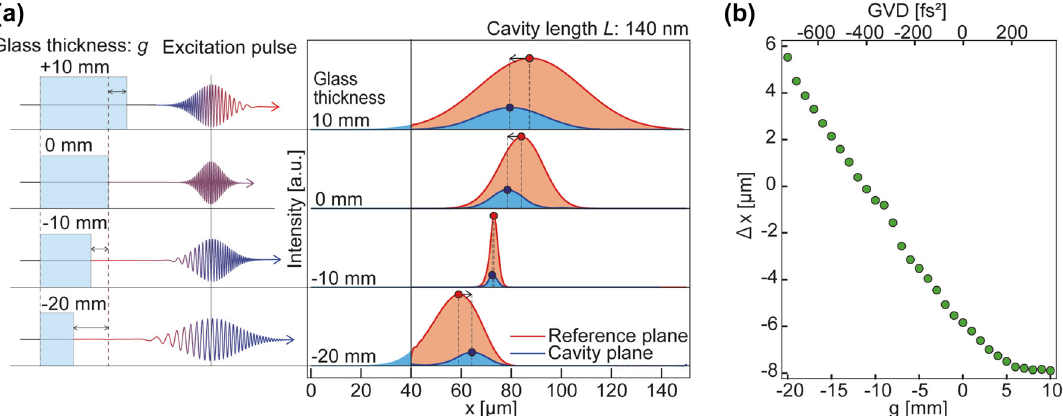
Figure 5: Control of peak shift of SPP WP by the chirp-induced excitation pulse. (a) Envelope shape of SPP WP calculated by CD model for reference plane (red plots) and cavity plane (blue plots) containing MIM-NC with L = 140 nm under several chirped pulse conditions. The red andbluecirclesindicatethecoordinatesoftheintensitymaximaoftheSPPWPsinthereferenceandcavityplanes,respectively.Thetemporal waveformsof achirp-inducedexcitationpulseareschematically shown.The groupvelocity dispersion(GVD)ofeach pulsecorrespondsto the amountofchirpcausedbythetransmissionofthesilicaglasswitheffectivethickness g = − 20to10mm.(b)Extentofpeakshift( Δ x)ofSPPWP after transmission through MIM-NC as function of thickness of silica glass or GVD applied to the excitation pulse (see Supplementary S2 for